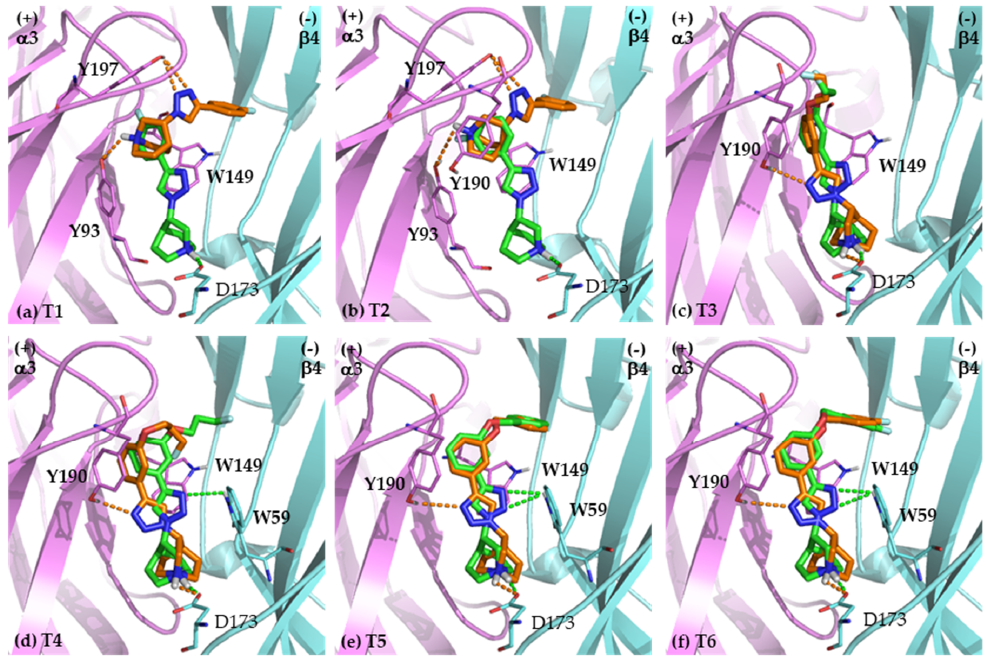
Figure 4. The docking poses to α3β4 nAChR of the ( R )-enantiomers (orange) and the ( S )-enantiomers (green) of T1-T6 ( a – f ). The amino acid residues forming hydrogen bond, cation-π, and π-π interactions are shown. The polar hydrogen atoms of the interacting amino acid side chains are displayed to identify hydrogen bond donors and acceptors. The conserved residues are shown in bold. Pink, α3 nAChR; cyan, β4 nAChR; red, oxygen; blue, nitrogen; orange dashed lines, hydrogen bond interaction with ( R )-enantiomers; green dashed lines, hydrogen bond interaction with ( S )-enantiomers.